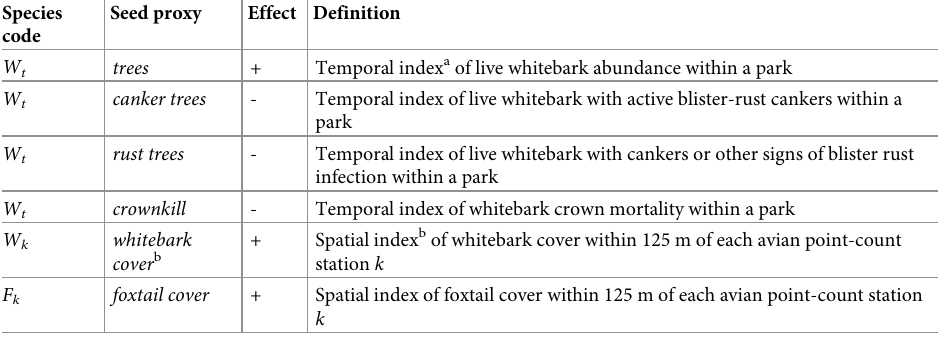
Table 3. Proxies of seed production by whitebark ( W ) or foxtail ( F ) pine, and their hypothesized effects on Clark’s nutcracker density in national parks. Species code